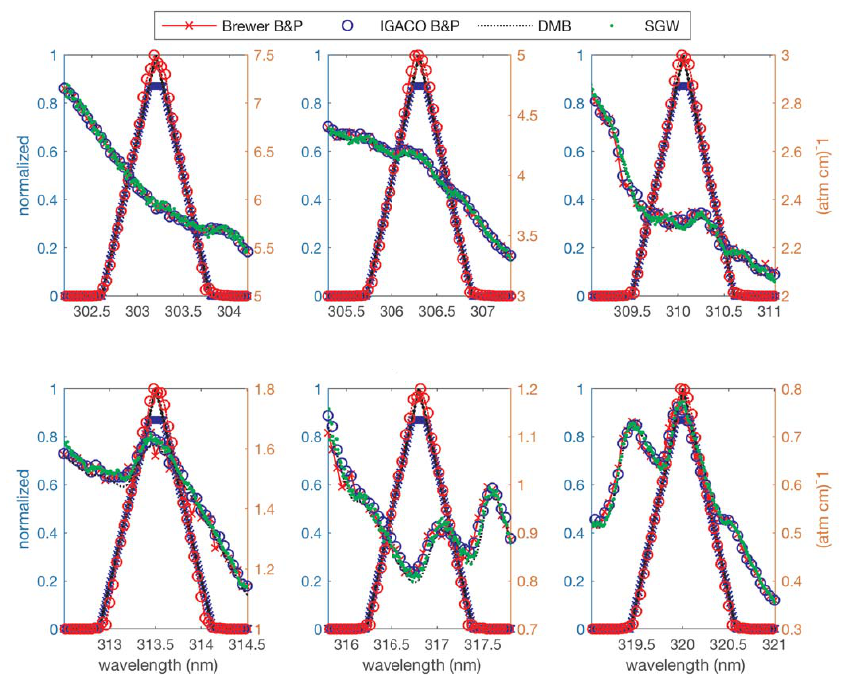
Figure 6. Plot of the parametrized (thick lines, left axis) and the measured slit functions (dots, left axis), as well as the different ozone cross-sections in cm − 1 (right axis) used for the Brewer effective ozone absorption coefficient calculation. Table 3. Ozone absorption coefficients in atm cm − 1 calculated using four ozone absorption cross-sections, together with the trapezoidal and the triangular parametrization of the slit functions, as well as the directly measured slit functions. Percentage difference is also given between the absorption coefficients yielded by the parameterized and the directly measured slit functions. Trapezoid Triangular Measured % Trapezoid % Triangular BRW 0.3381